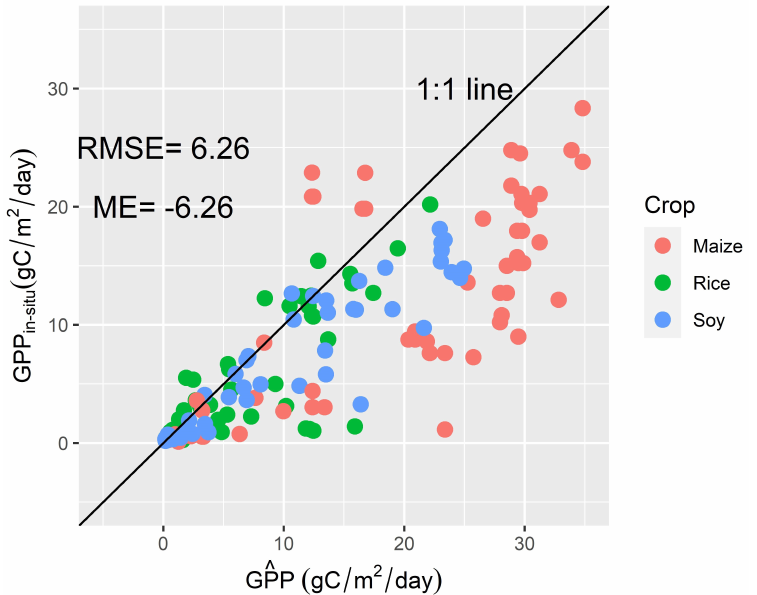
Figure 7. Predicted Gross Primary Productivity ( ˆ GPP ) with fixed maximum light use efficiency values against GPP in situ from flux tower sites in Table 1. Root mean square error (RMSE) and mean error (ME) between observed and predicted observations are